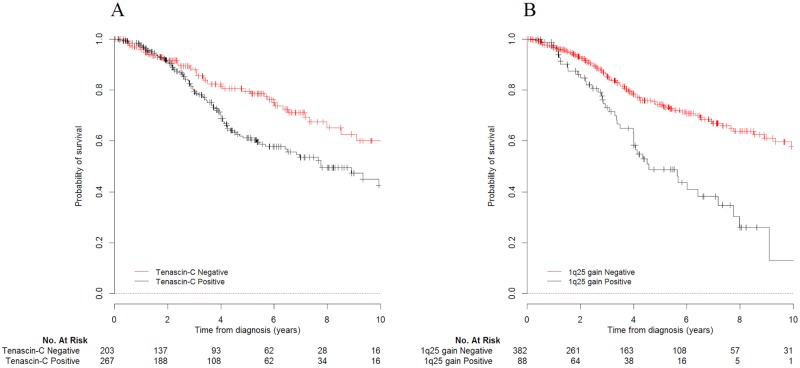
Kaplan-Meier-based overall survival curves according to Tenascin-C (negative (43%), positive (57%)) (A) and 1q25 gain (negative (81%), positive (19%)) (B) (n = 470).The hazard ratios (HR) and 95% confidence intervals, estimated through a univariate Cox model stratified by cohort, were for TNC: HRpos vs neg = 1.586 [1.105; 2.277] (p = 0.012) and for 1q25 gain: HRpos vs neg = 2.490 [1.721; 3.605] (p<0.0001).